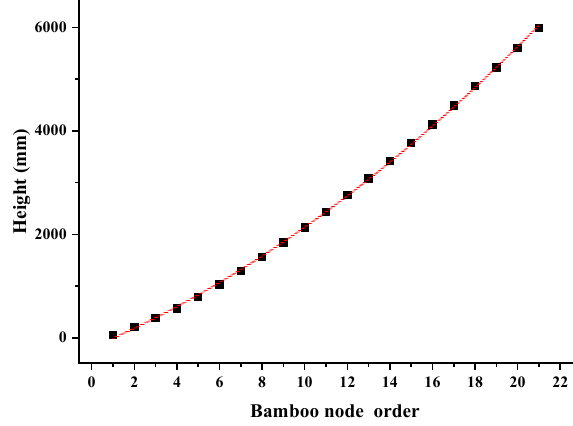
Figure 5. Height statistics of bamboo nodes.